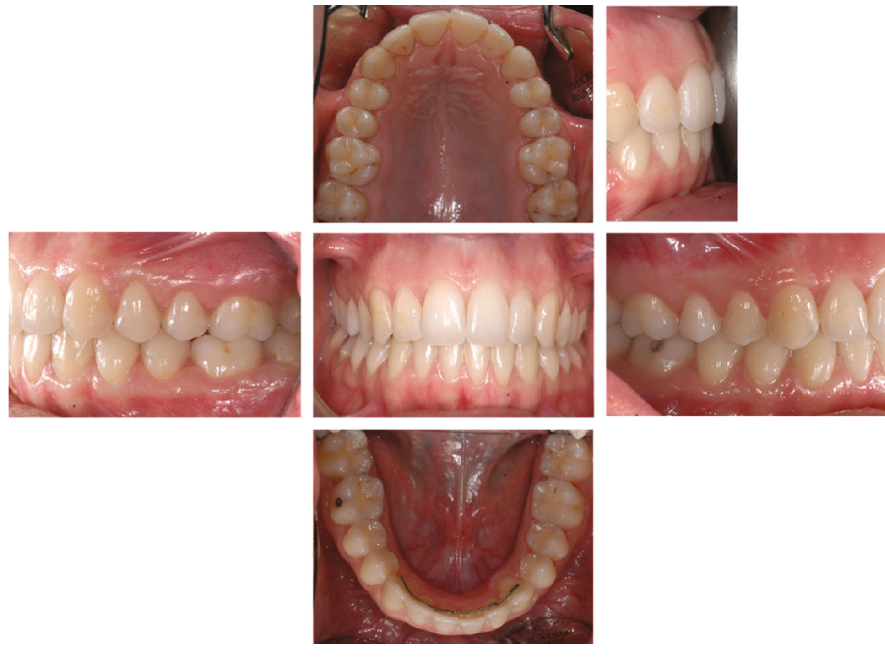
Figure 18: 10-year follow-up intraoral photographs.